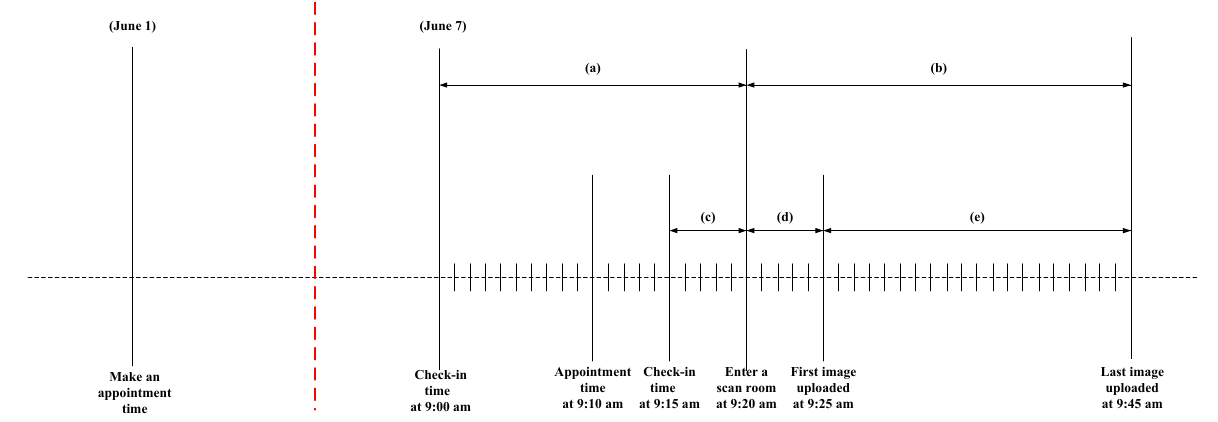
Figure 1. An example of the recorded time for a patient’s scanning appointment procedures at the case hospital.